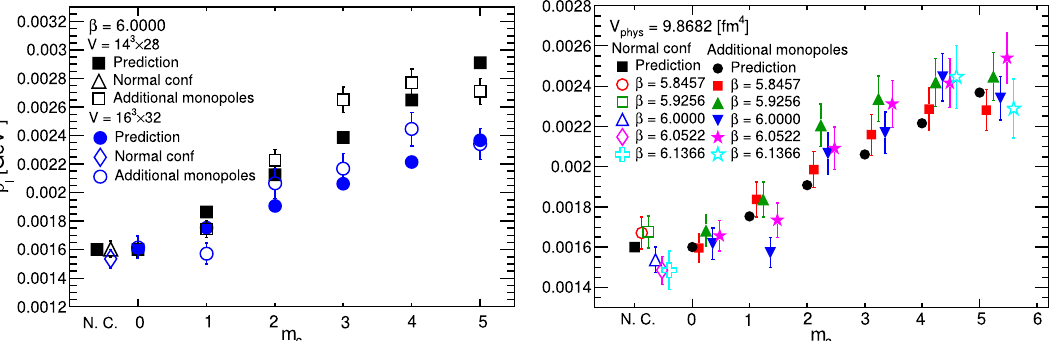
Fig. 7 Examining the effects of the finite lattice volume (left) and the discretization (right) on the fitting results of the slope A N of β = 6 . 0000 , V = 14 4 and β = 6 . 0522 , V = 18 3 × 32 are reported in our previous research [41,42]